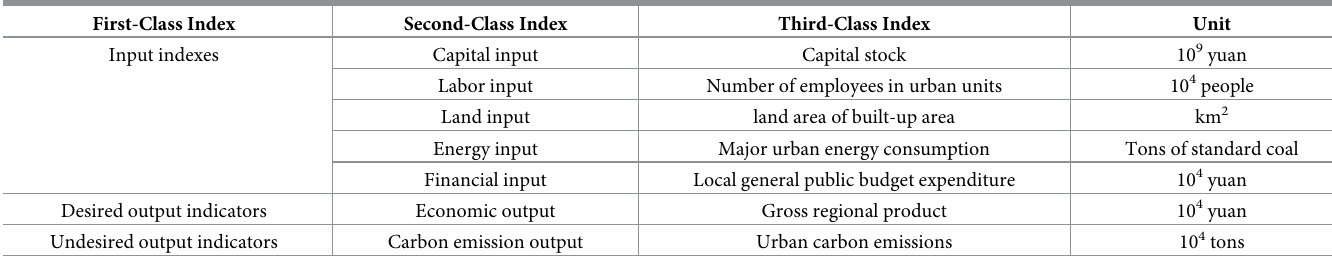
Table 1. Index system of ULEE